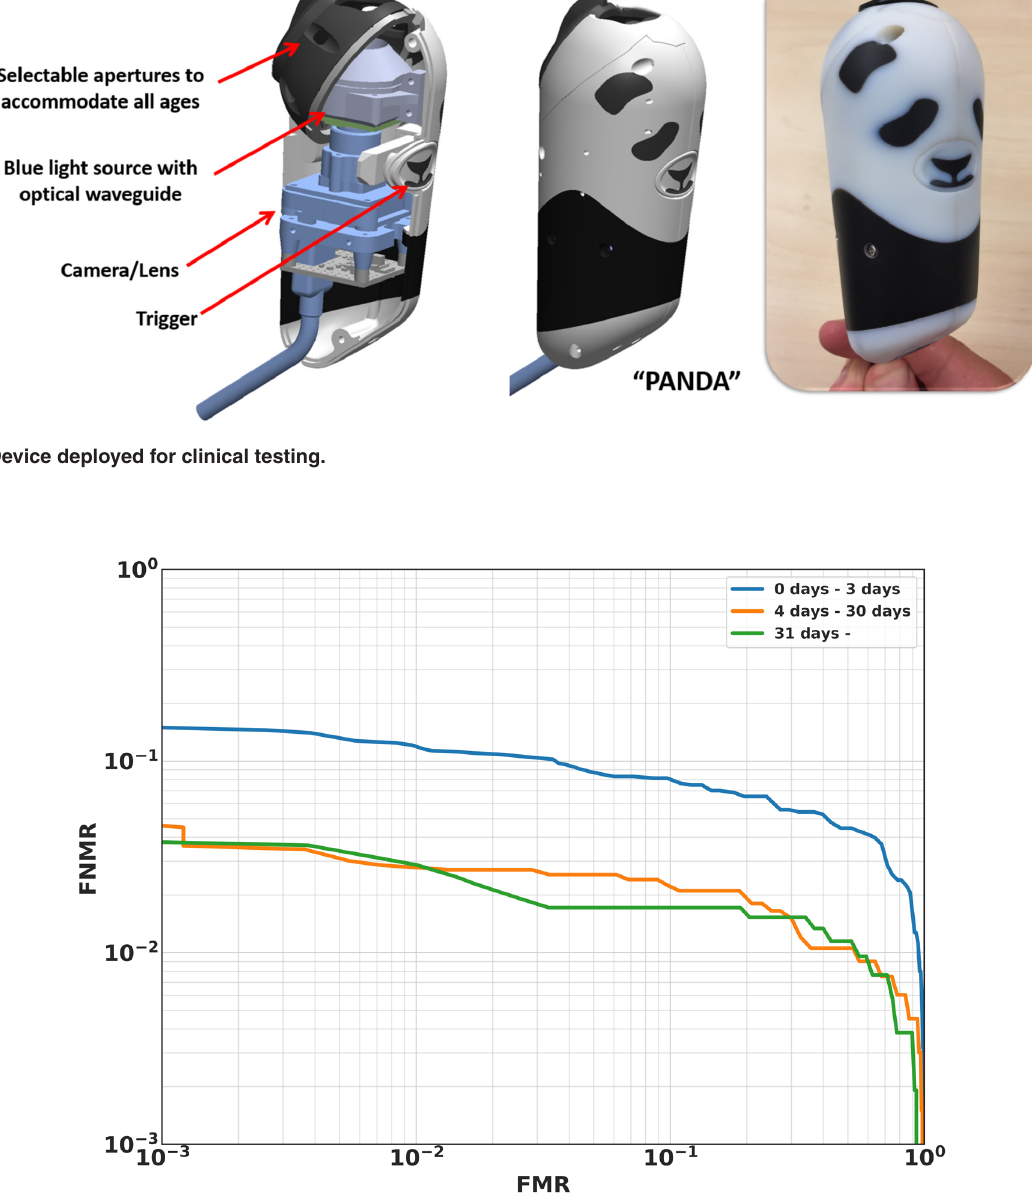
Figure 22. Preliminary Detection Error Tradeoff